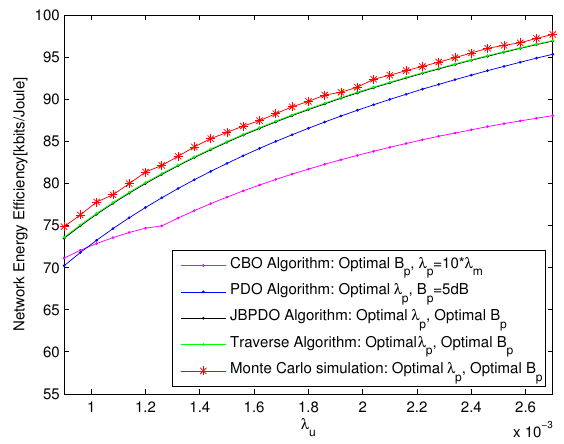
Figure 6. The network EE versus λ u with different optimization algorithms.